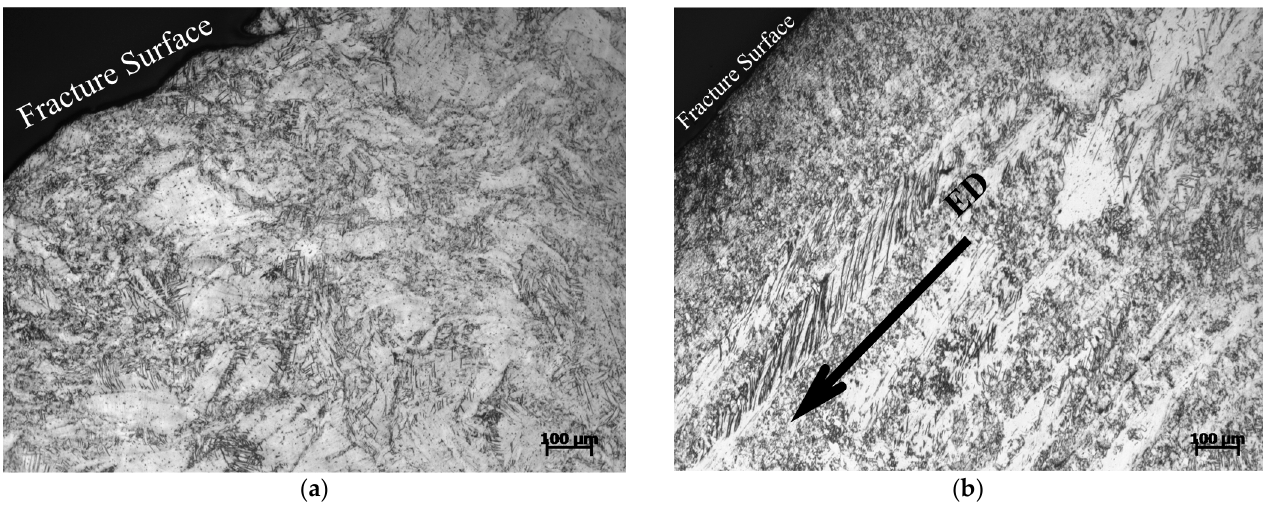
Figure 14. Micro-morphology of Mg-Al-Ca-Mn alloy fractured in ( a ) ND and ( b ) vertical 45° direction.